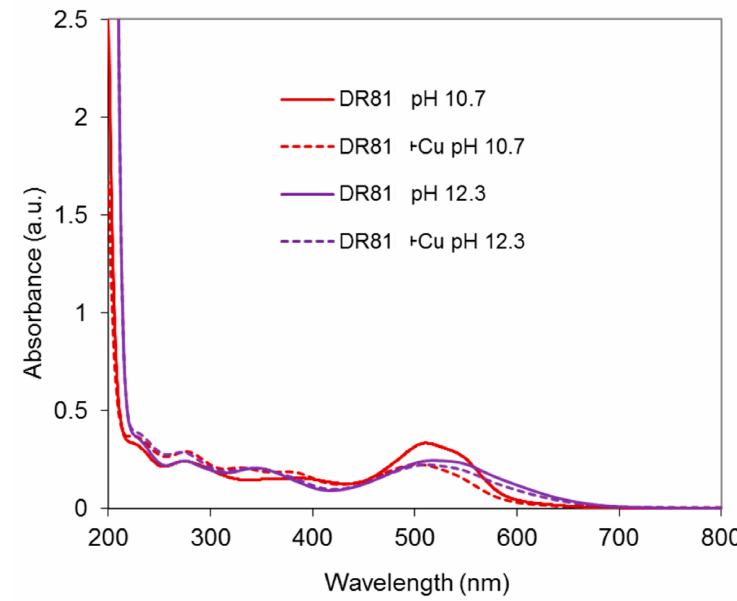
Figure 10. Absorbance spectra of the dye/copper sulfate system at pH 10.7 and 12.3, with DR81:CuSO 4 molar ratio= 1:1.5 and [DR81] = 10 µ M, compared to the dye alone at the same pHs.